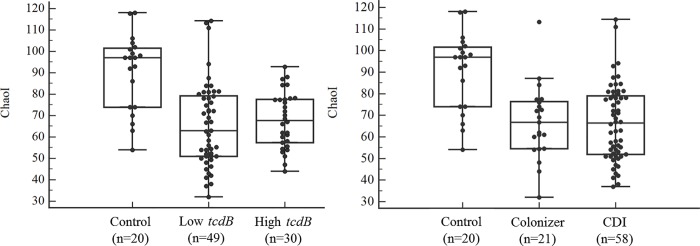
Alpha diversity in control and each category of tcdB positive patients.The distribution of ChaoI diversity index was presented between groups (A, control, low and high tcdB; B, control, colonizer and CDI, respectively). Black dot line, median value; gray horizontal line, interquartile value.